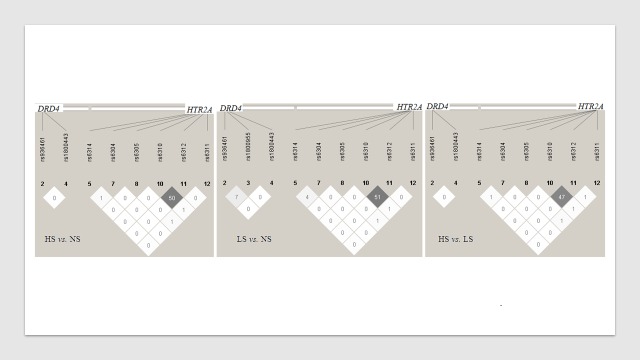
Haplotypes for DRD4 and HTR2A in each comparison of the study groups.Show values of r squared in diamond. HS, Heavy smokers; LS, Light smokers; NS, Non-smokers.